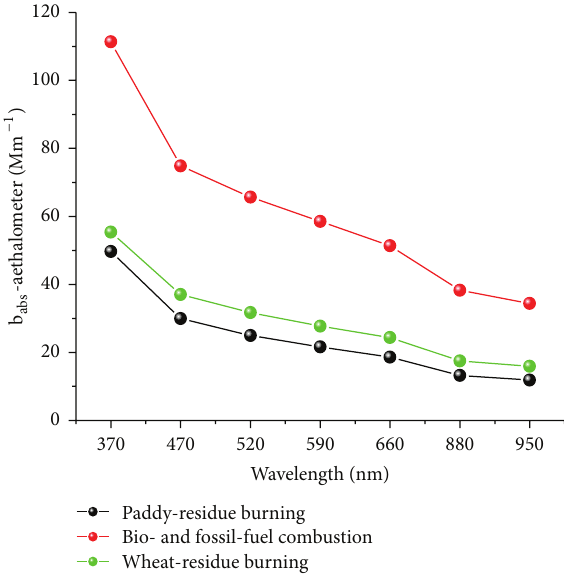
Figure 3: The spectral variation of averaged absorption coefficient ) of BC during different emissions in this ( 𝑏 abs